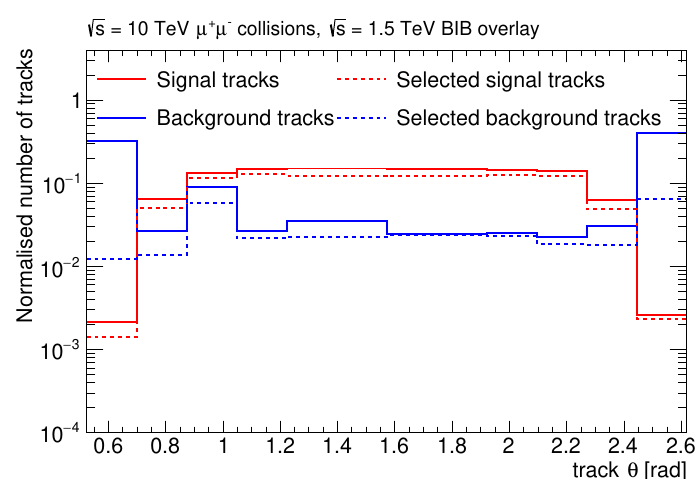
Figure 10. Distribution of the polar angle of the reconstructed tracks, and after all track quality requirements. Signal tracks are presented in red, while background tracks originating from the BIB in blue. The histograms are normalised to unit area. The dashed lines show the effect of the requirements imposed on the track d , χ 2 / N.d.f and number of holes. The signal track distributions 0 are taken from a wino signal sample with m (˜ χ ± ) = 500 GeV. A track is considered as signal if the hits matched to the generator-level ˜ χ ± compose more than 70% of the total hits associated to the track. Background tracks are composed exclusively by hits from the